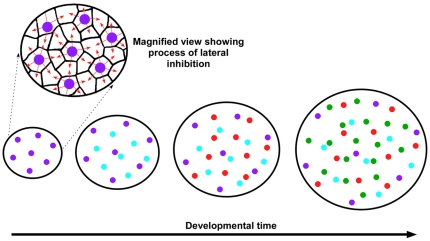
A model for the formation of the photoreceptor mosaics of the chicken.In this model the individual photoreceptor types establish their spacing in a series of temporally discrete waves. The least abundant photoreceptor type (i.e., violet cones) establishes spacing first, possibly via a lateral inhibition mechanism (far left). Then, the next most abundant photoreceptor type, blue cones, establishes its spacing. This process continues until spacing has been established for all photoreceptor types (the diagram only shows the four single cone types). The addition of subsequent waves of photoreceptors results in a relatively uniform expansion of the epithelium and a concomitant ‘spacing out’ of those photoreceptor types whose spacing was established earlier. Since spacing is established in discrete steps, all photoreceptor types can, in principle, employ the same biochemical mechanism to establish spacing.